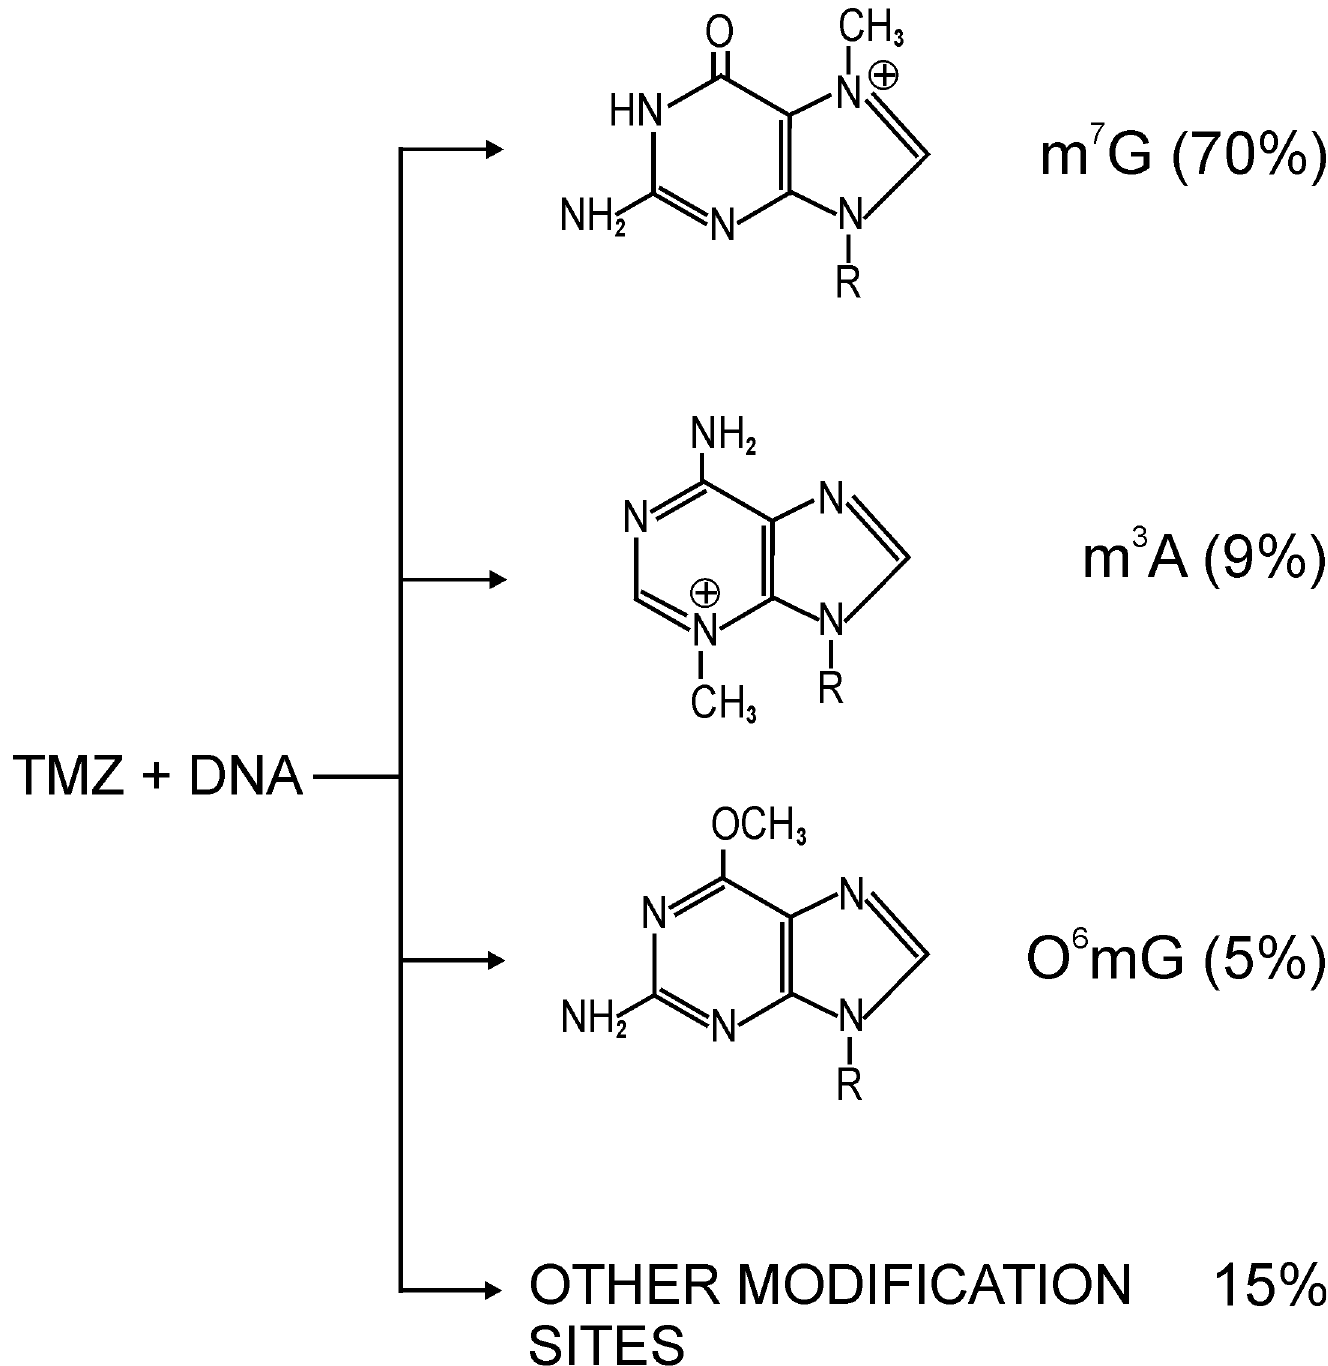
Fig 1. Site specific DNA methylation with temozolomide. The main product of DNA reaction with TMZ is 7- methylguanosine (m 7 G). Methylation of O6 guanosine is supposed to be the main mechanism of TMZ action, but takes place only in 5%.